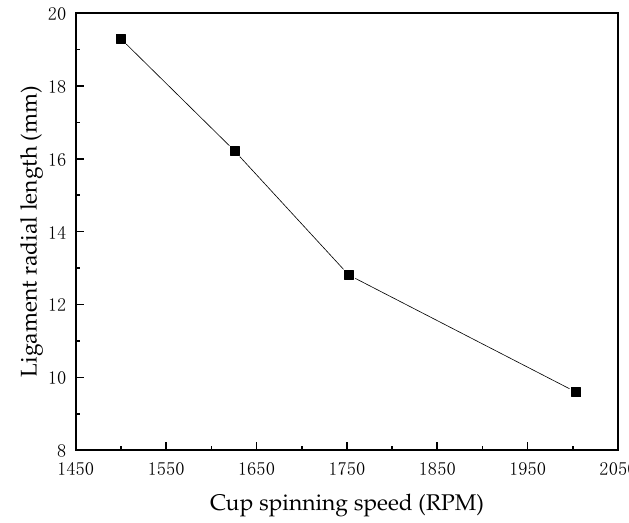
Figure 10. Effect of cup spinning speed on ligament radial length.